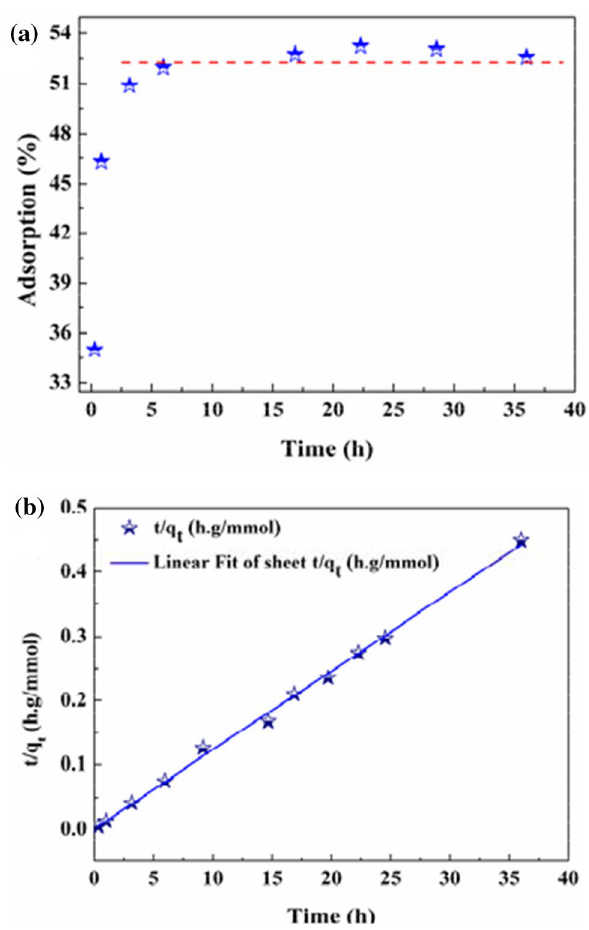
Fig. 5 a Effects of pH value and ionic strength on the adsorp- tion percentage of Pb2+ on 3D AFC surface, and b the dis- tribution of Pb2 + in different pH states. m/V = 0.4 g/L, [Pb2 +]0 = 4.8 × 10–4 mol/L, I = 0.001 M NaCl, T = 25